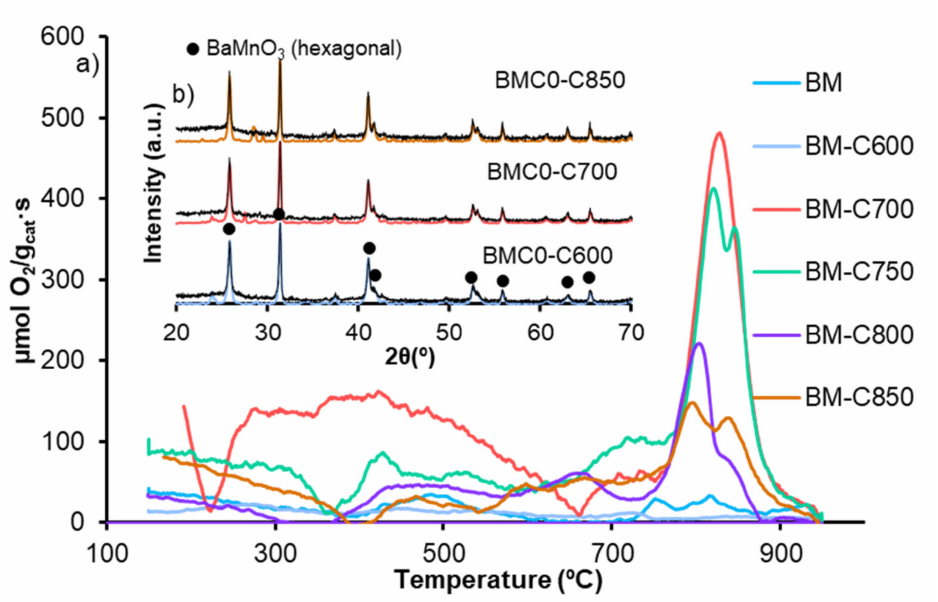
Figure 8. ( a ) O 2 -TPD profiles of BM-CX series and BM as reference and ( b ) X-ray patterns of fresh (col- ored line) and used (black line) BM-C600, BM-C700 and BM-C850 as representative BM-CX